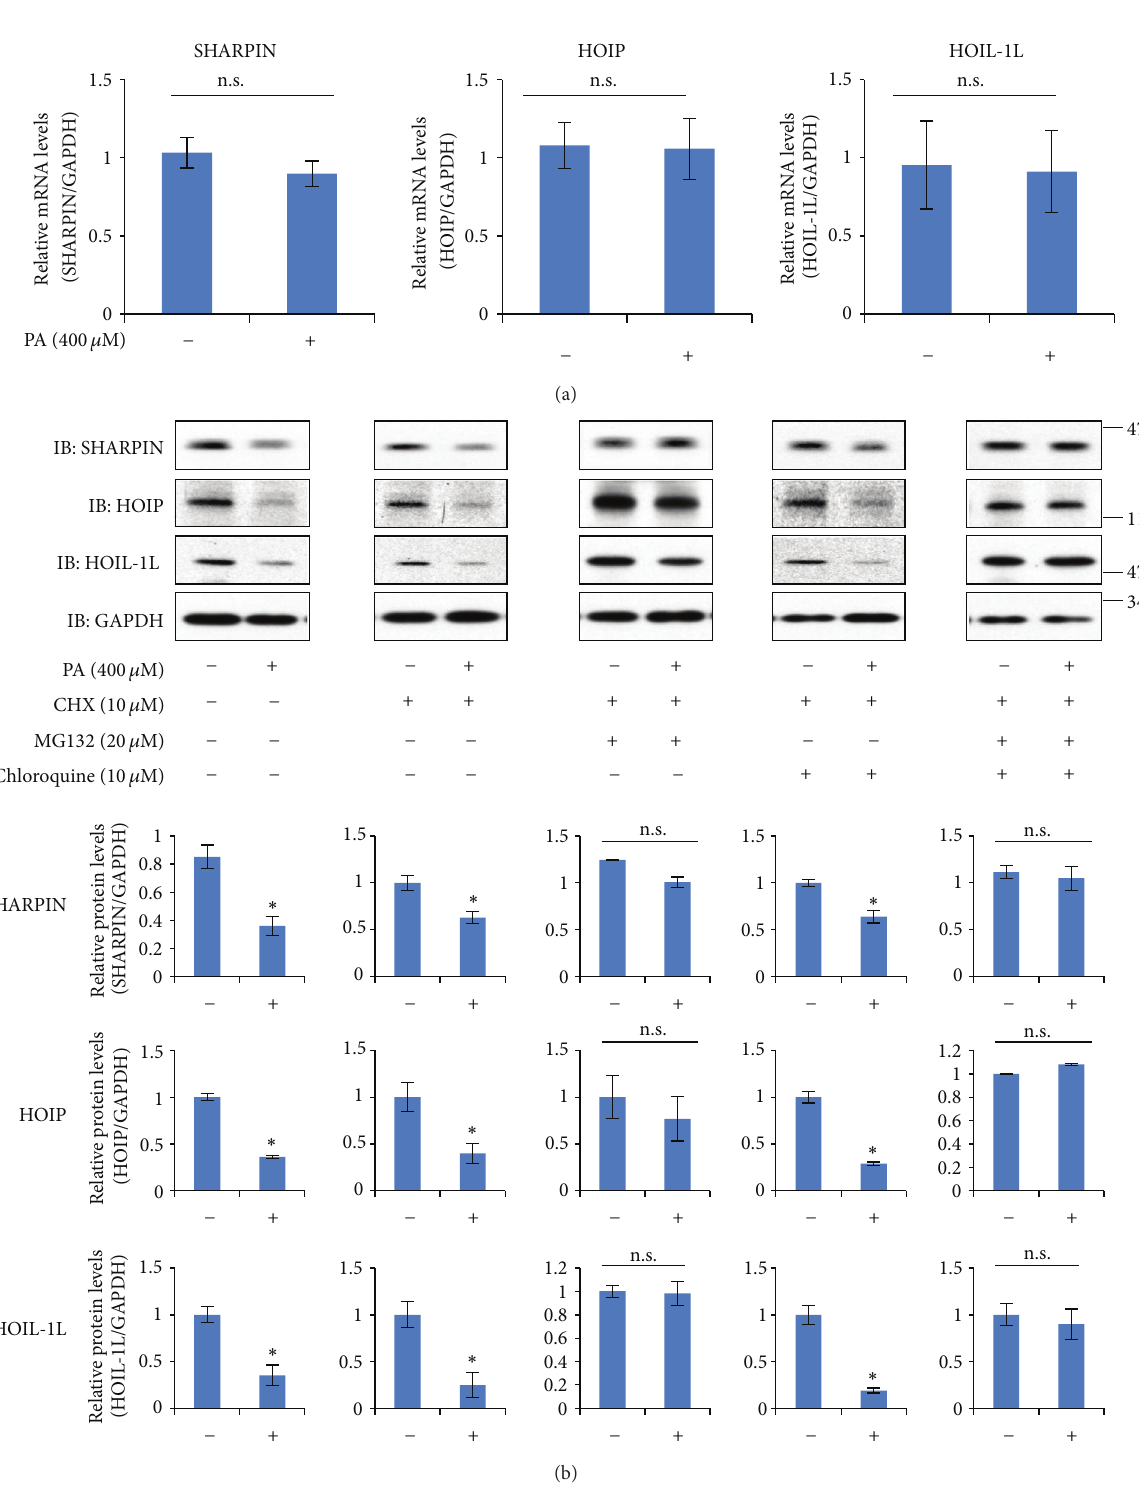
Figure 5: (a) HepG2 cells were incubated in the presence or absence of palmitate. After incubation for 12hr, total RNA was extracted and reverse transcribed, and the mRNA levels of SHARPIN, HOIP, and HOIL-1L were quantified by real-time PCR. As the housekeeping gene, GAPDH was used for quantity normalization. The results shown are means ± S.E.M. ( 𝑛 = 5 ). n.s.: not significant. (b) HepG2 cells were incubated with the indicated combination of 20 𝜇 M MG132, 10 𝜇 M chloroquine, and 10 𝜇 M cycloheximide, in the presence or absence of palmitate for 24hr. Cell lysates were harvested in lysis buffer and expressions of SHARPIN, HOIP, and HOI-1L were determined by immunoblotting using the corresponding antibodies. For each combination, a representative immunoblot is shown and quantified data are expressed as the percentage ± S.E.M of five independent experiments. ( 𝑛 = 5 ). n.s.: not